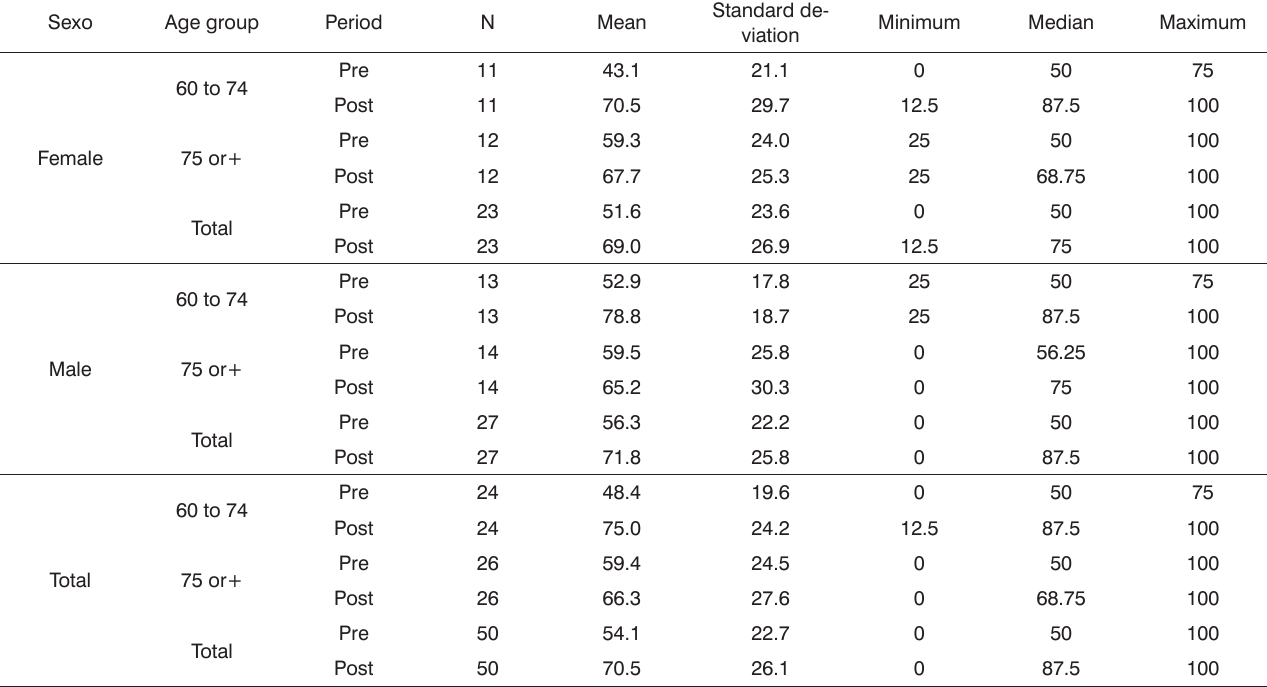
Table 8. Analysis of variance and descriptive statistics for the social aspect according to sex and age group.